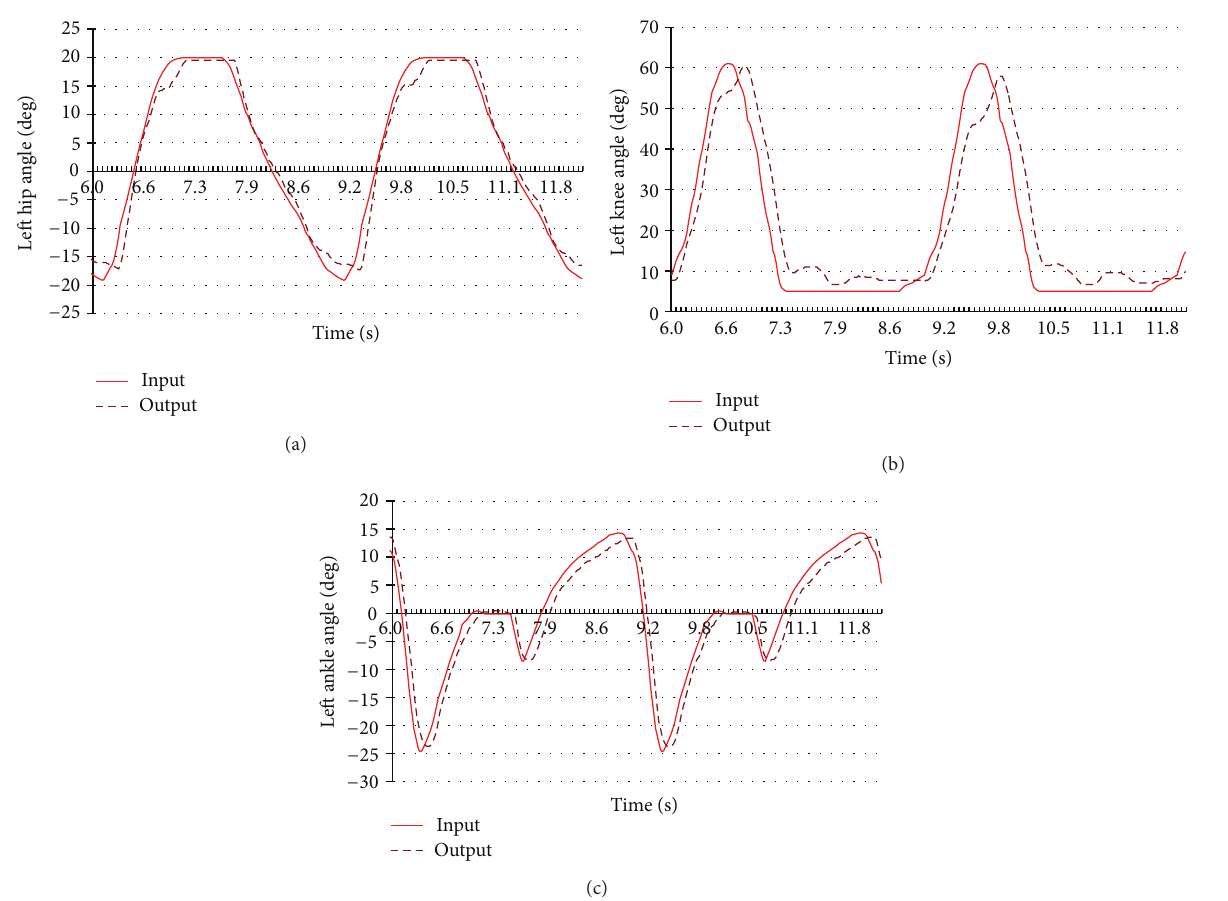
Figure 7: Comparison between P.I.G.R.O. input-output joints angles curves in hip (a), knee (b), and ankle